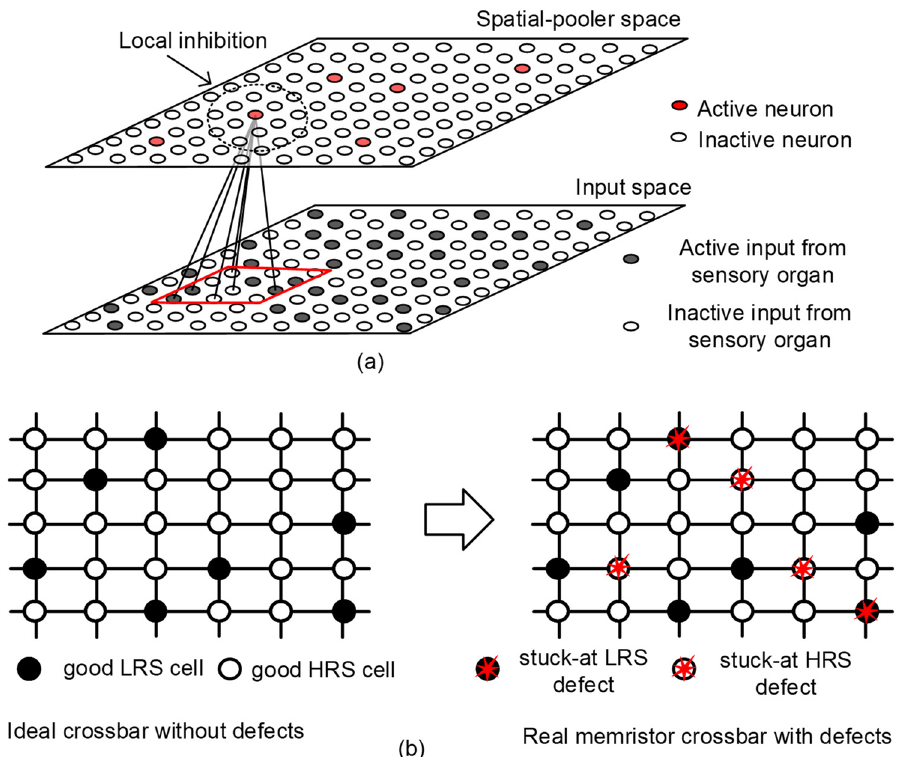
Figure 1. ( a ) The conceptual diagram of Spatial Pooler (SP) operation, where the input-space neurons are mapped to the SP neurons; and ( b ) the comparison of the ideal crossbar without defects and the real crossbar with defects. LRS and HRS mean Low Resistance State and High Resistance State, respectively.